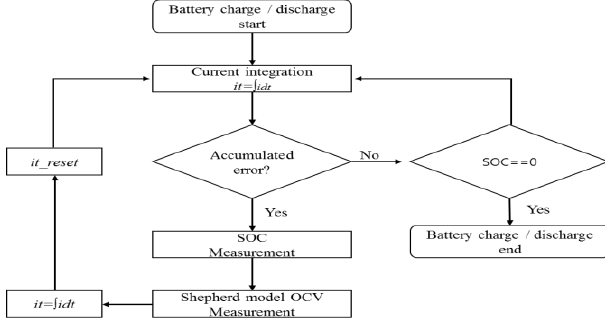
Figure 6. Flowchart of the proposed state-of-charge (SOC) estimation algorithm.